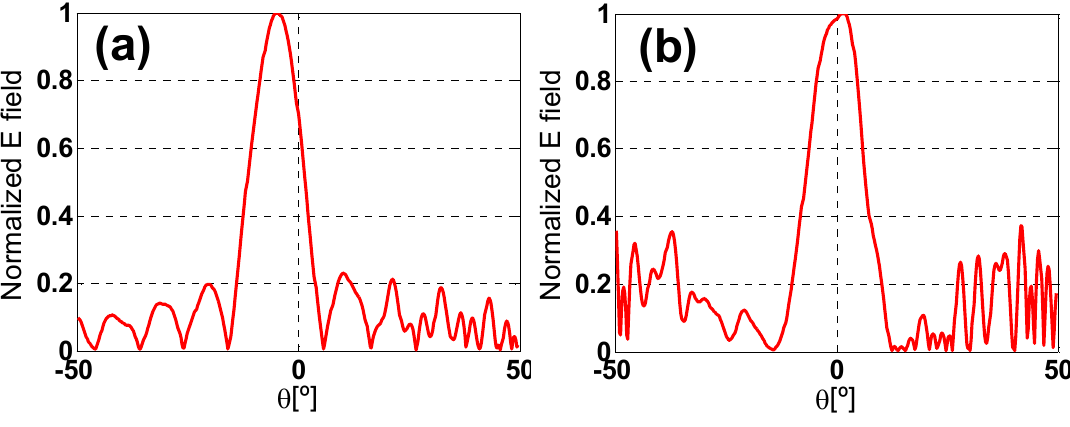
Figure 17. Scattered field pattern in an anechoic chamber: ( a ) TE and ( b ) TM.